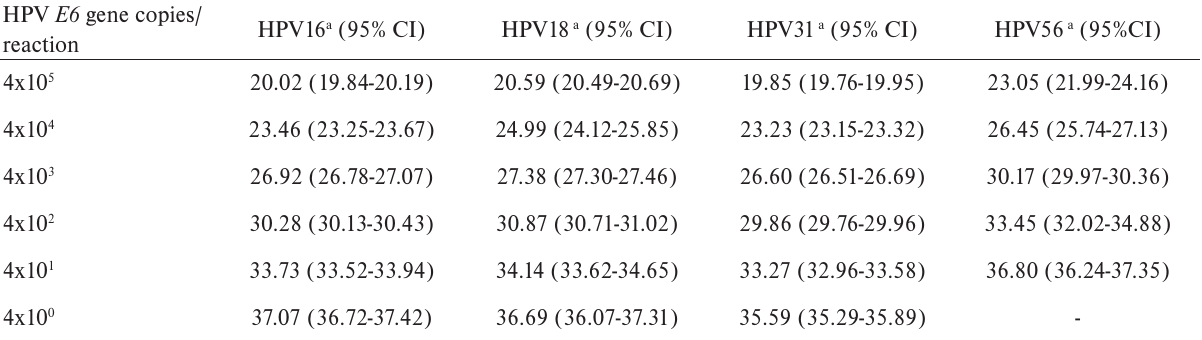
Table 3. Evaluation of the detection limit of the qPCR